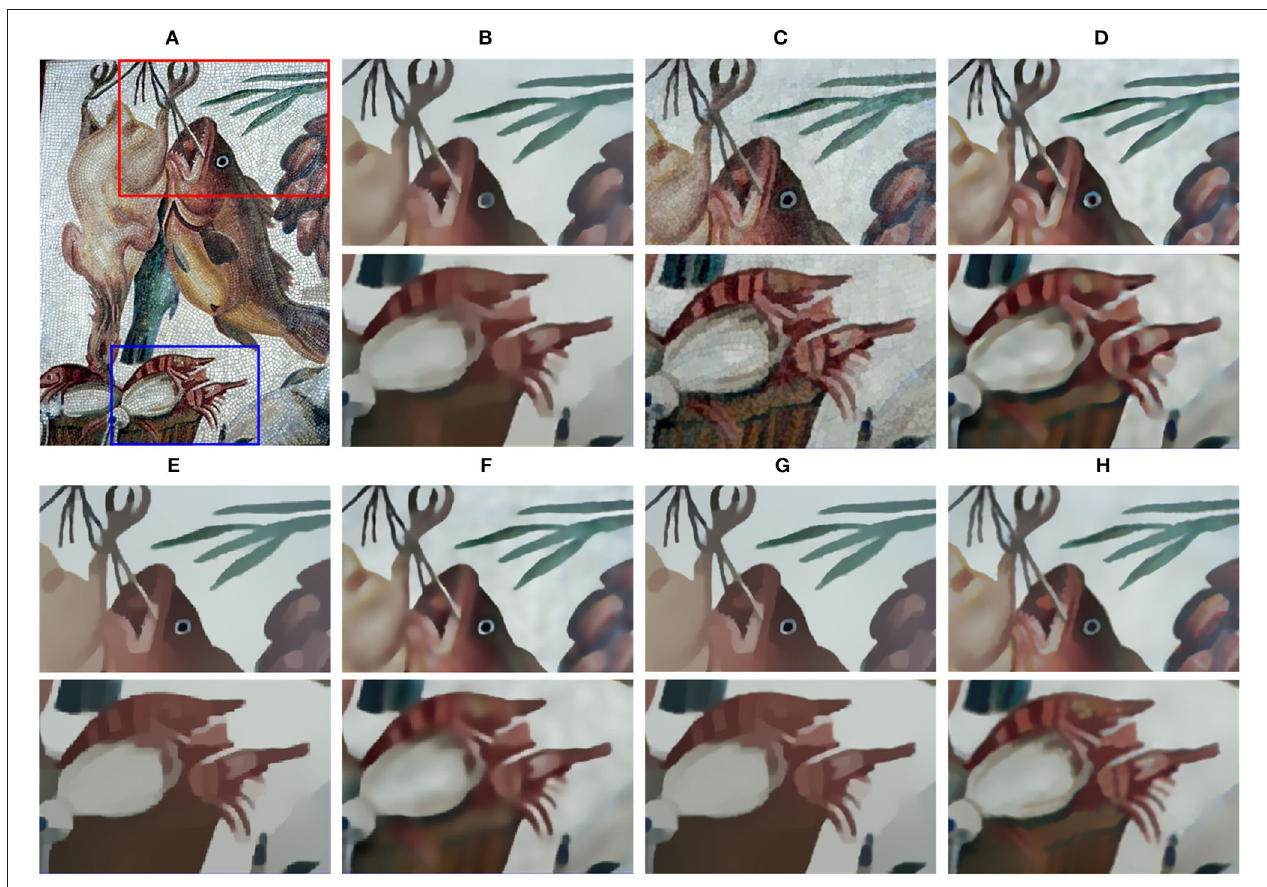
FIGURE 6 | Small structures comparison of different filtering results. (A) Input image; (B) RTV ( λ = 0.015, σ = 6); (C) SGTD ( mu = 0.31); (D) RGF ( σ s = 4, σ r = 0.05); (E) BTF ( k = 9); (F) SATF ( sr = 0.1, se = 0.05); (G) ROG ( σ 1 = 1, σ 2 = 3); (H) ours ( σ r = 25, η = 10, I = 2). Reproduced with permission from Hyunjoon Lee, Junho Jeon, Junho Kim and Seungyong Lee, available at https://sci-hub.wf/10.1111/cgf.12875.